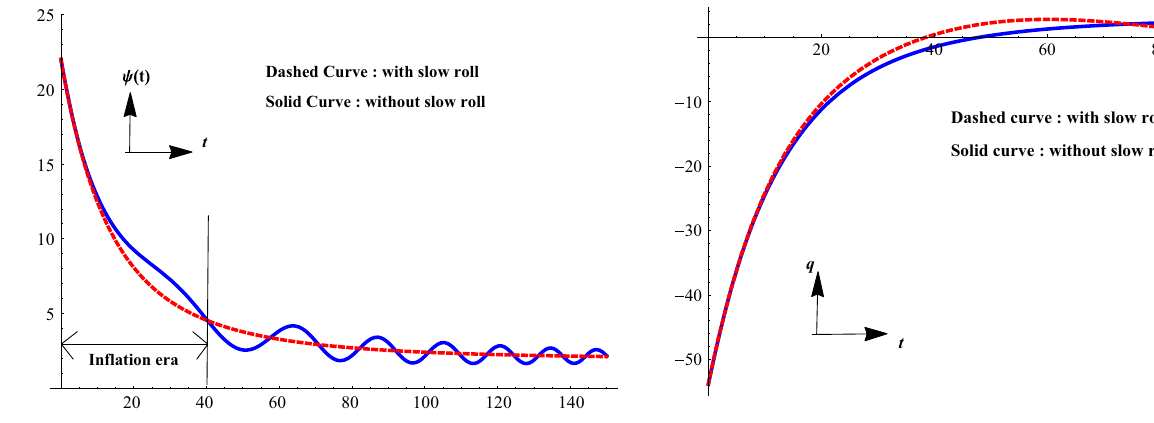
Fig. 4 (cid:13)( t ) vs. t with/without slow roll approximation for m rad = 10 − 4 (in Planck units)